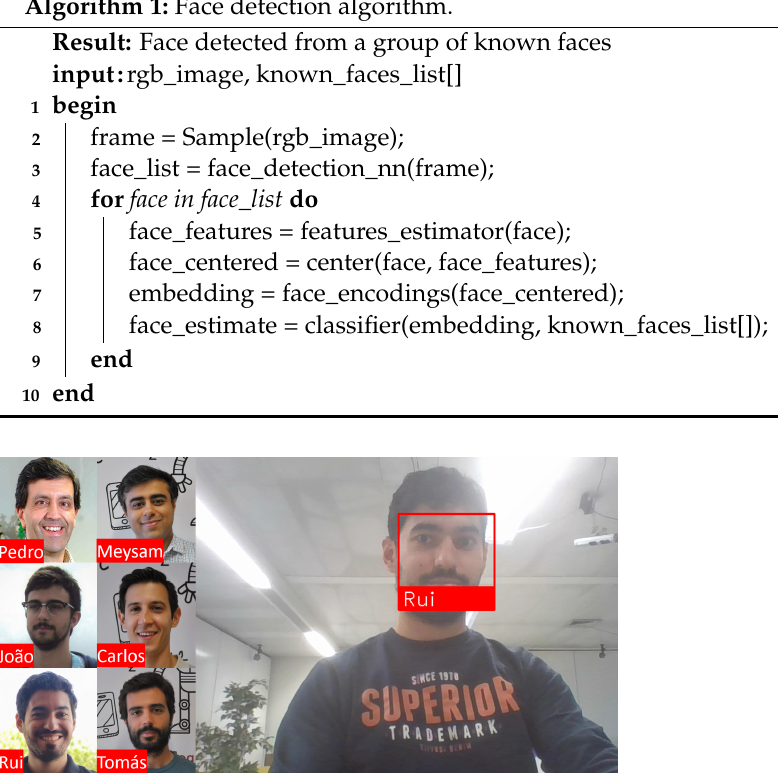
Algorithm 1: Face detection algorithm.